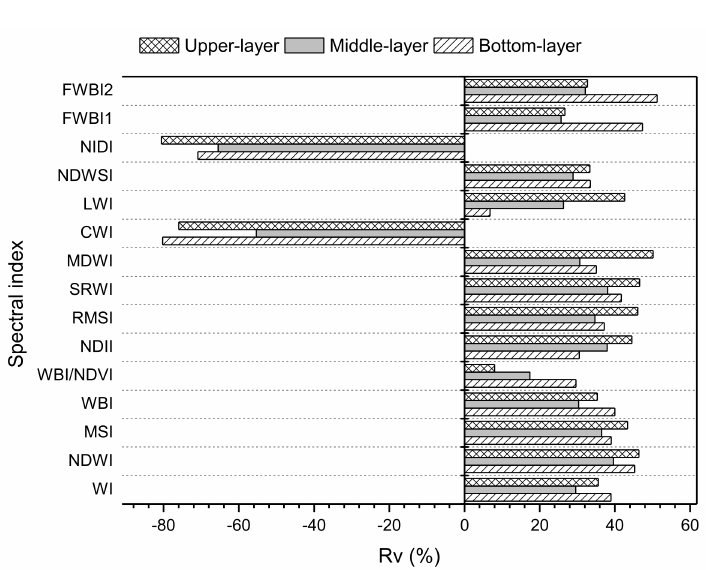
Figure 5. The relative variation rate ( R v ) of R 2 of relationships between published spectral indices and LWC in the upper-, middle- and bottom-layer before and after removing